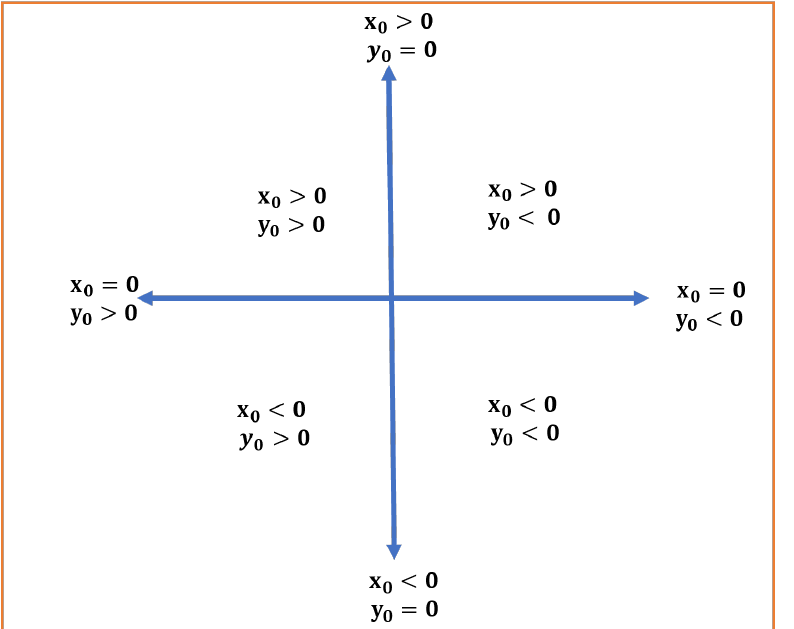
Figure 2. Variation of sign and value of asymmetric parameters that determines the direction of opening of crescent-shaped intensity pattern exhibited by asymmetric LG